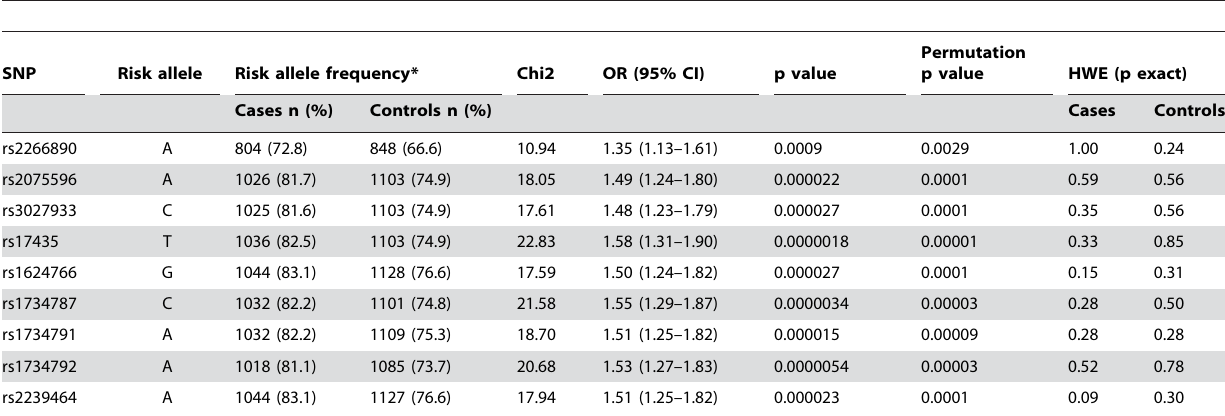
Table 2. Allele frequencies of SNPs in the MECP2 gene region genotyped in Korean SLE patients and that have a minor allele frequency of . 0.05